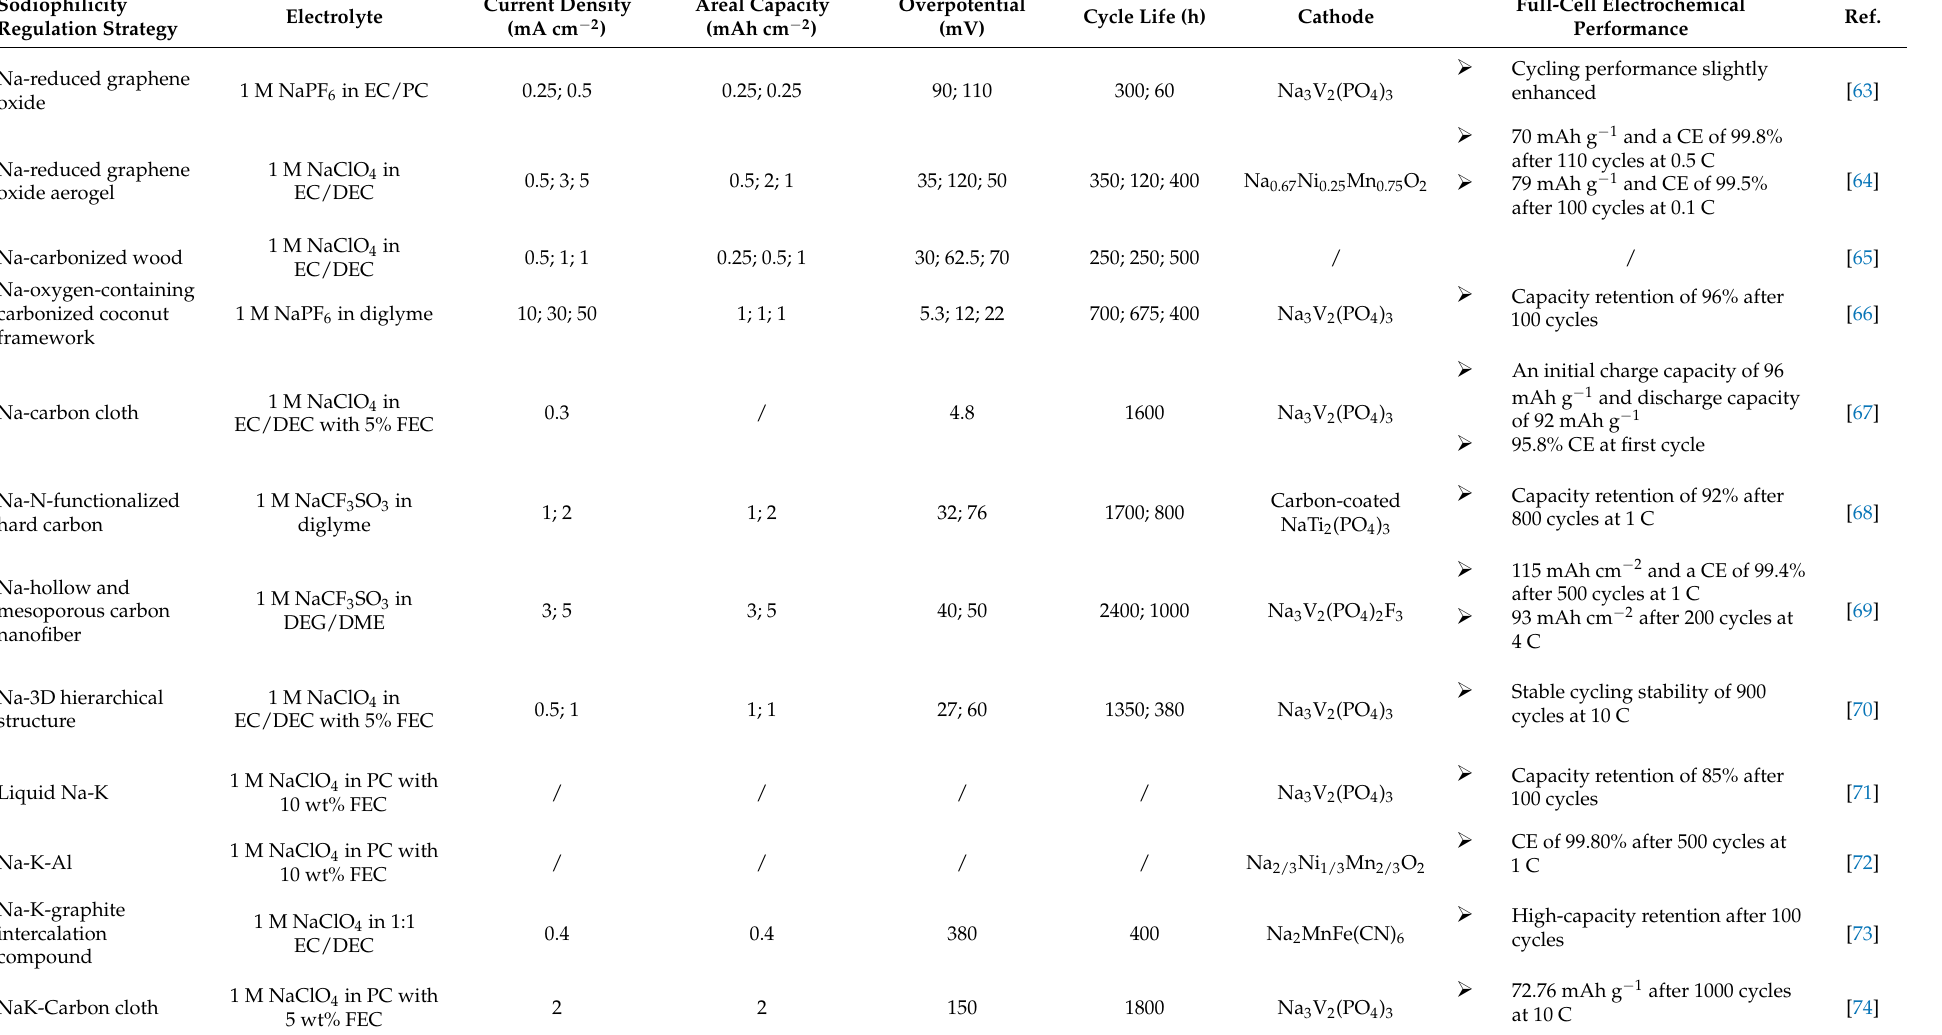
Table 2. Comparison of electrochemical performance of Na metal anodes modified by different wet- tability-enhancing strategies.